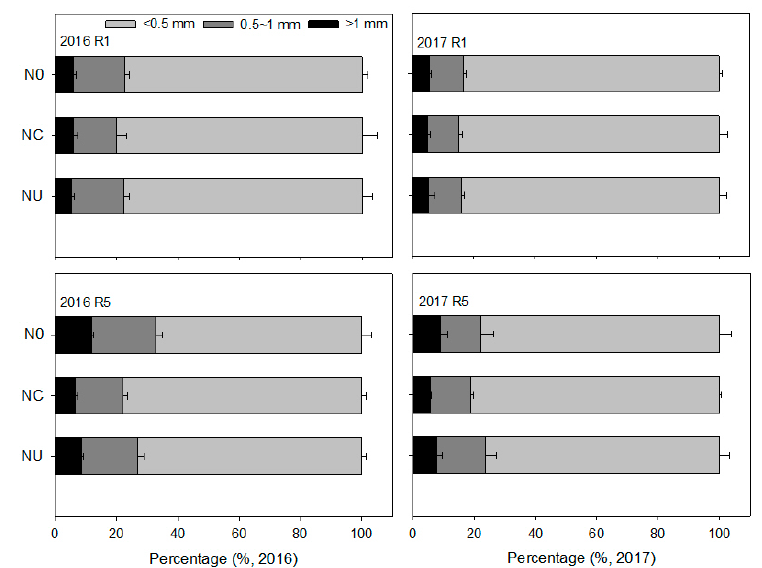
Figure 5. Average root diameter classes as affected by different N application treatments at R1 and R5 stages in 2016 and 2017 as follows: no N application (N0), combined controlled release urea and normal urea at a ratio of 1:2 (NC), and normal urea alone (NU).